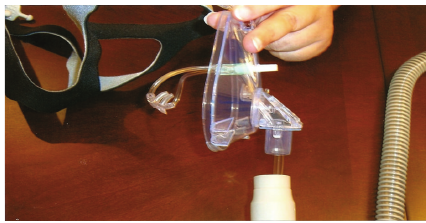
Figure 2: Lateral view of dual mask, nasal cannula can be directly applied to the patient nostril and eliminate dilution effect secondary to